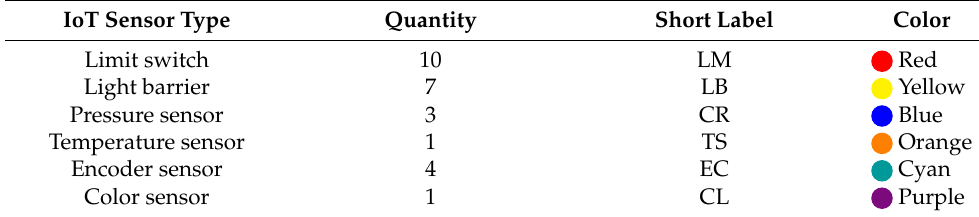
Figure 14. Overview of components and sensors in the smart factory. Table 2. IoT sensors of smart factory with short label and color.